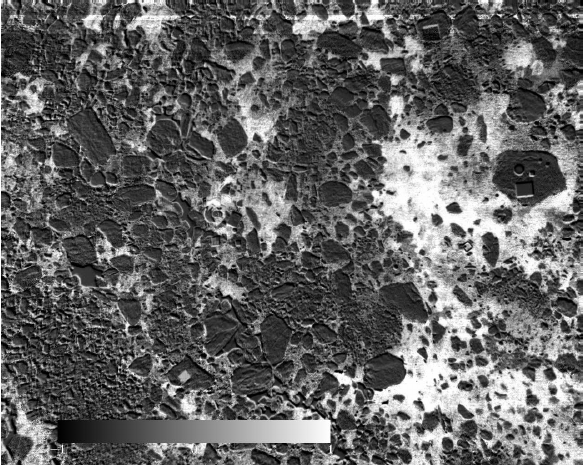
Figure 9: Normalised Difference Vegetation Index (NDVI) de- rived from the MCA